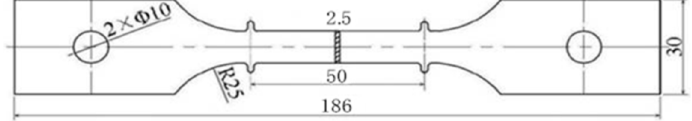
Figure 1. Geometry and dimensions of the creep specimen (unit: mm).